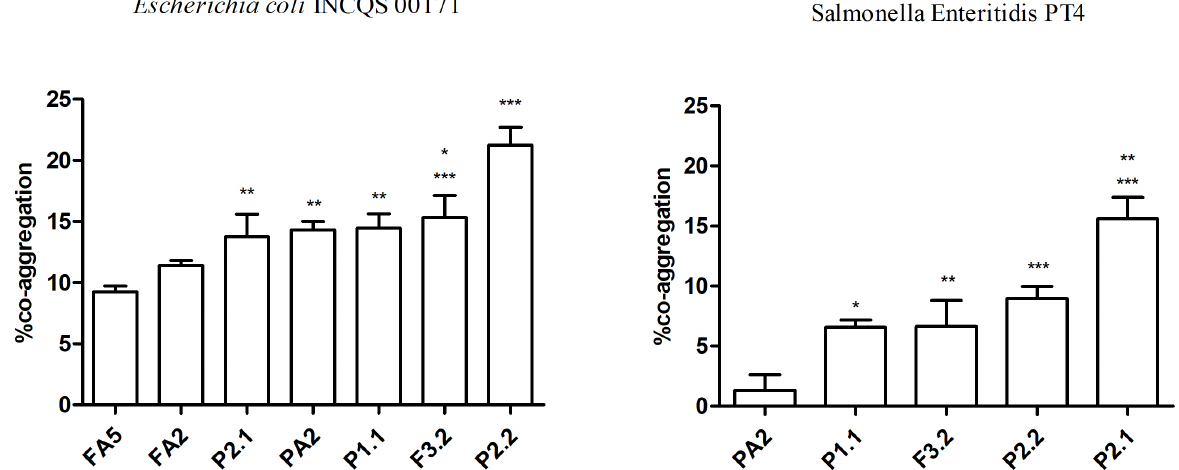
Figure 3. Co-aggregation after 5 hours of incubation. The percentage of co-aggregation evaluated the ability of lactobacilli to aggregate with pathogenic bacteria and was obtained from the measurement of absorbance before and after a 5 hours incubation. (*) represents statistical difference of p<0.05, (**) represents statistical difference of p<0.01 and (***) represents statistical difference of p<0.001. With E.coli , P2.2 was statistically different from all other strains studied (***); F3.2 was statistically different from FA2 (*) and FA5 (***); P1.1, PA2 and P2.1 were statistically different from FA5 (**). With S.Enteritidis , P2.1 was statistically different from P2.2 (**) and all other strains studied (***); P2.2, F3.2 and P1.1 were statistically different from PA2 (***) (**) (*), respectively.